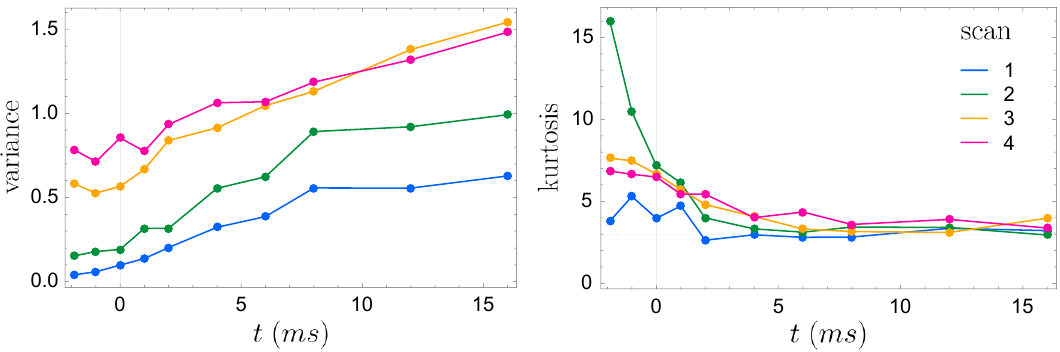
Figure 13: Time evolution of the variance ( left ) and kurtosis ( right ) of the phase difference distribution as a function of time t , in the four different scans. The variance increases, while the kurtosis tends to the Gaussian value (i.e., to